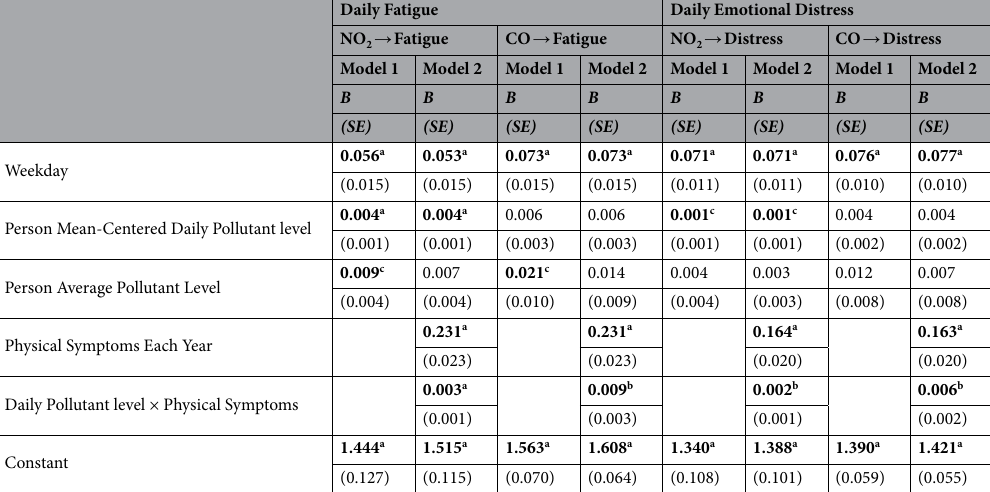
Table 1. Daily and average level associations between air pollutants NO 2 and CO predicting adolescents ′ fatigue and distress, using three level hierarchical linear regression models that nested days within years within individuals. Weekday was coded 1 = weekday 2 = not a weekday. Standard errors in parentheses. a p < 0.001, b p < 0.01, c p < 0.05. Significant associations are also